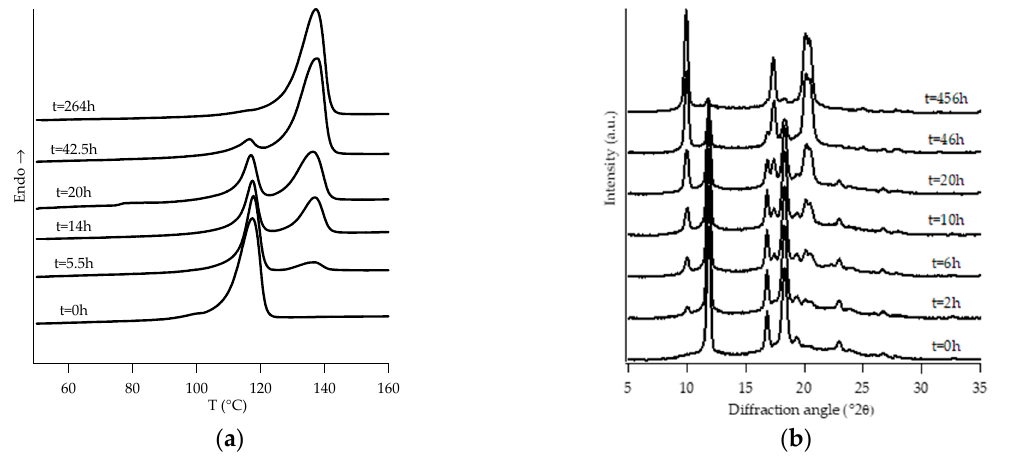
Figure 1. DTA thermograms ( a ) and WAXD patterns ( b ) of PB0 at different aging times.